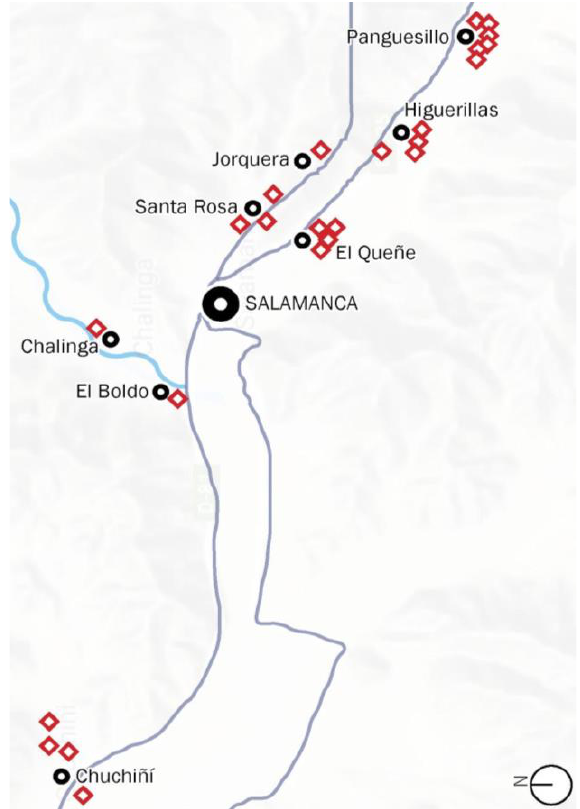
Figure 1. Location of the 24 studied ensembles (in red) within settlements of the commune of Salamanca (in